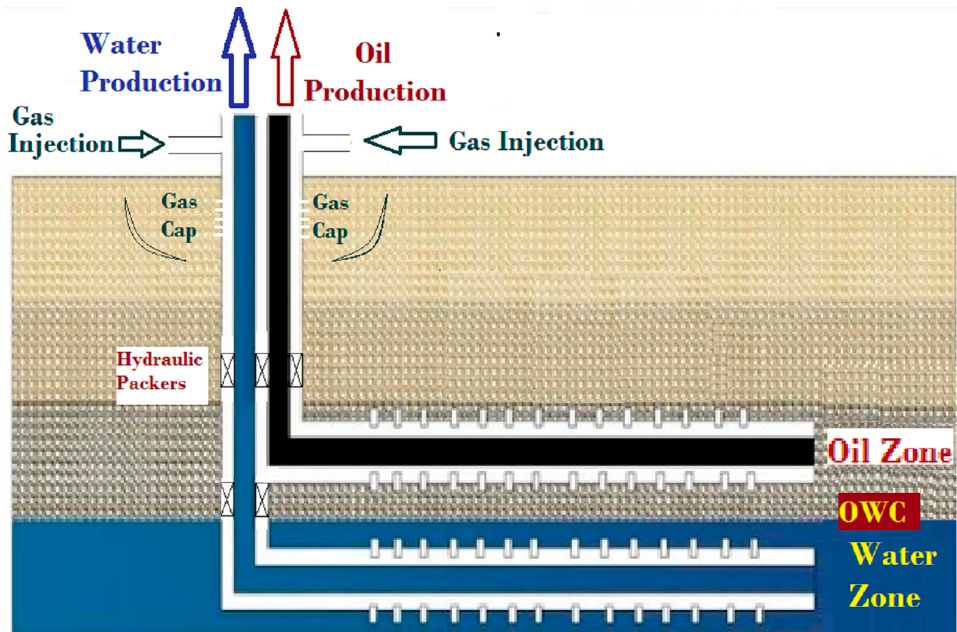
Figure 3. Schematic representation of the triple completions involved in a typical TC-GDWS-AGD-configured wellbore.